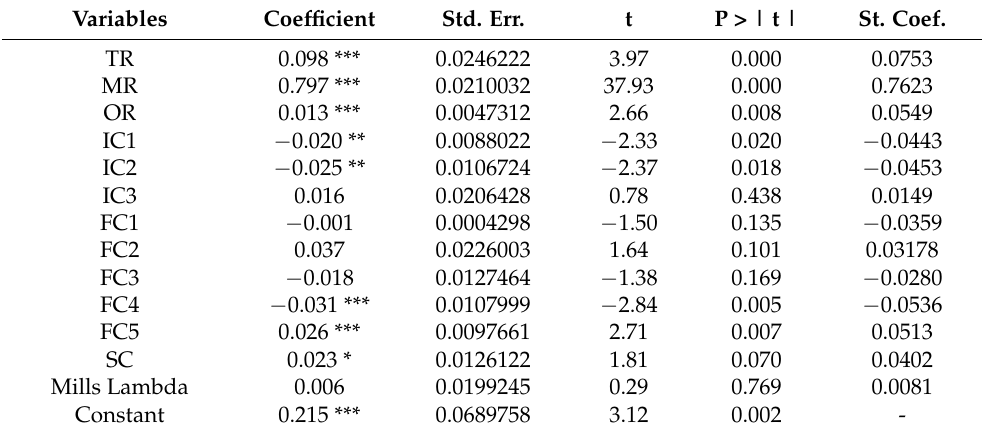
Table 5. Results of the second-stage selection estimation. Variables Coefficient Std.